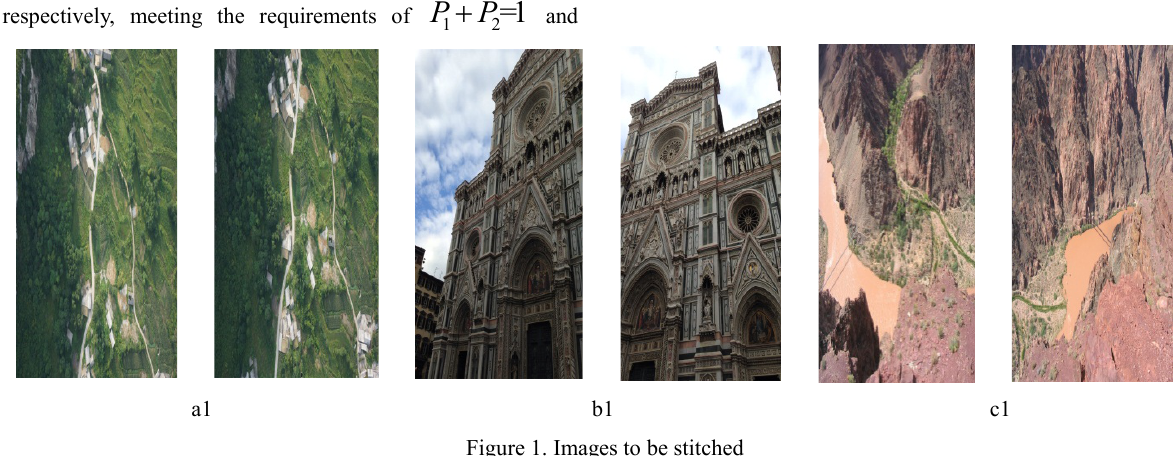
Figure 1. Images to be stitched